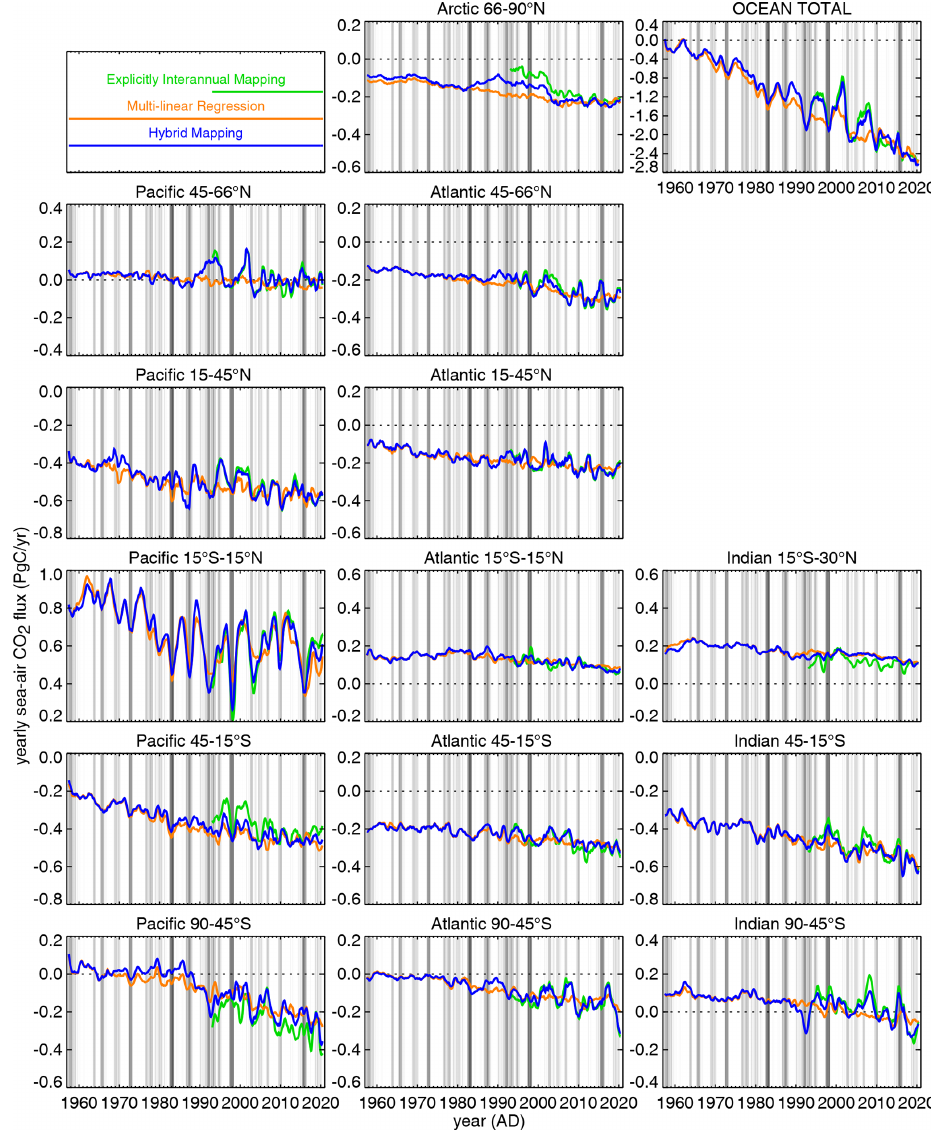
Figure 6. Yearly sea–air CO 2 flux as estimated from p CO 2 data by the explicitly interannual mapping (green; discarded before 1985, when the data constraint is very weak), the multi-linear regression (orange), and the hybrid mapping (blue). Fluxes have been integrated over a set of regions subdividing the ocean into basins (left to right) and latitude bands (top to bottom). For better temporal orientation across panels, the grey vertical background stripes indicate the positive phases of El Niño–Southern Oscillation according to the multivariate El Niño index (MEI) by Wolter and Timlin